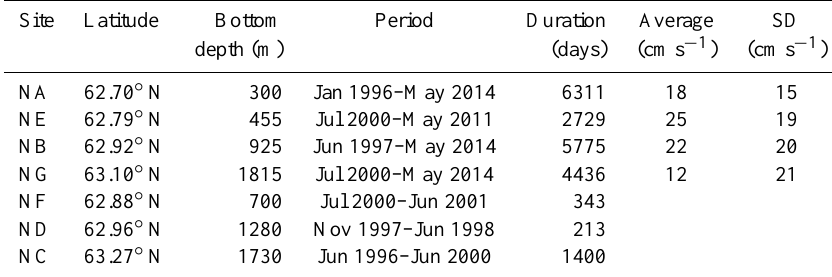
Table 1. Main characteristics of the measurements at the seven ADCP sites. For the four long-term deployment sites, the table also lists averages and standard deviations of the extrapolated eastward surface velocity. Site Latitude Bottom Period Duration Average depth